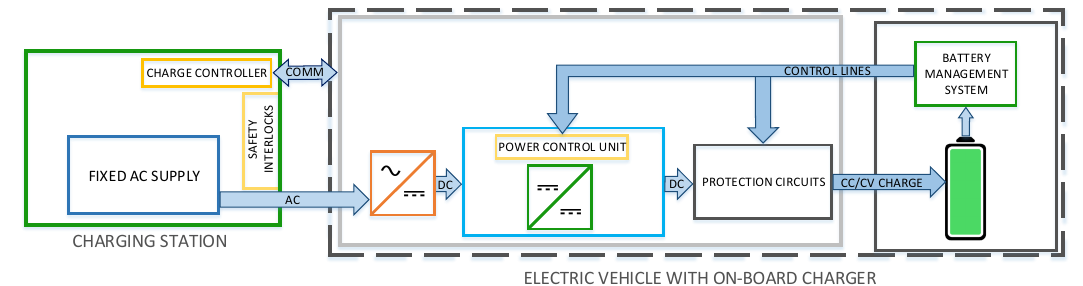
Figure 1. Conventional AC on-board charger configuration.